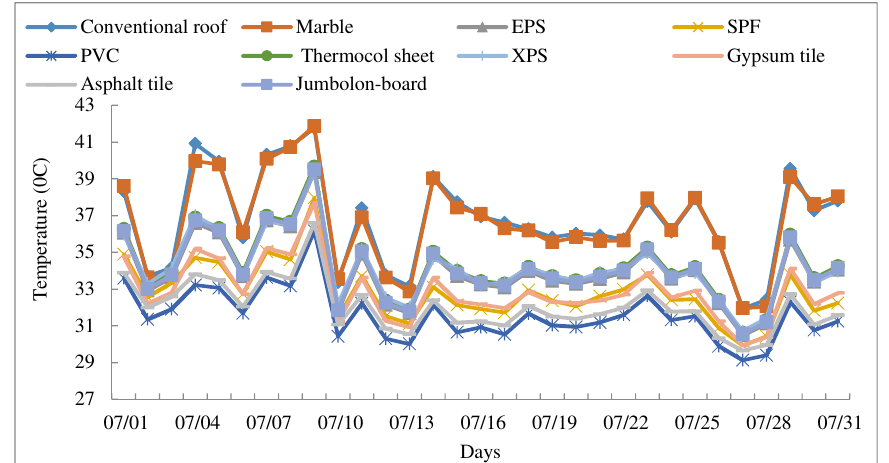
Fig. 2: Daily trends of roof outside surface temperature